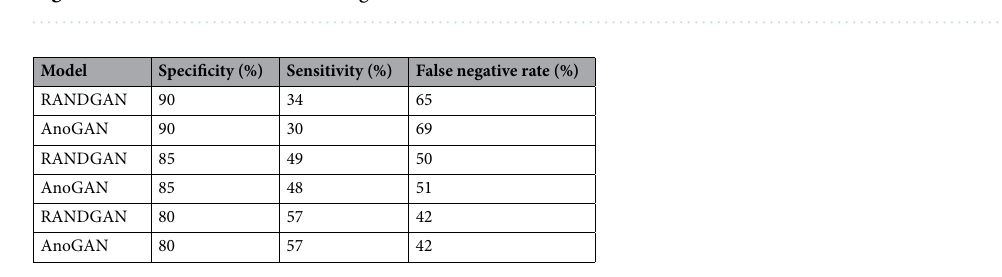
Figure 6. ROC curve of the trained generative models.